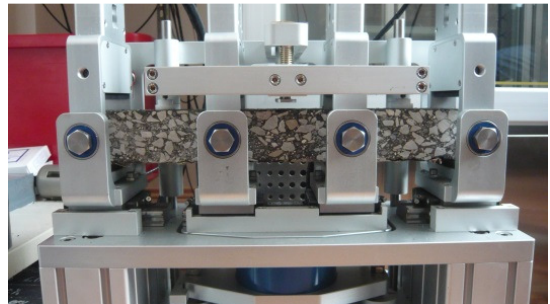
Fig. 6. Test equipment for fatigue test